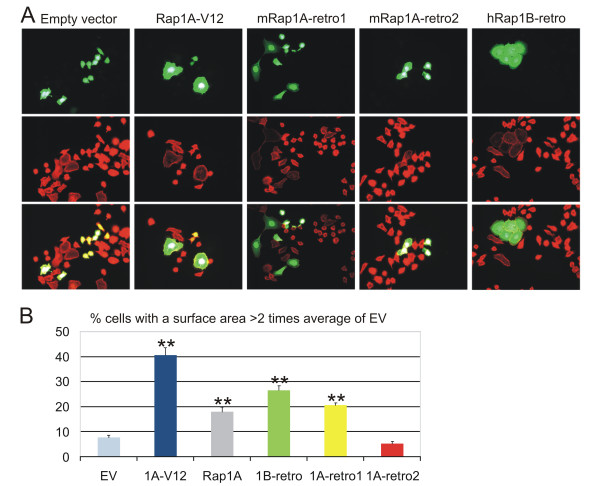
Analysis of the effect of mRap1A-retro1, -retro2 and hRa1pB-retro on cell spreading. A. A431 cells were co-transfected with histon2B-GFP and Rap1 constructs as indicated. Cells were grown overnight in tissue culture wells and then photographed. GFP-positive cells were visualized by phalloidin (red) staining. B. For cell spreading, first we determined the average surface of >100 non-transfected cells using the ImageJ program. Next, the surface of at least 90 transfected cells (selected on the basis of the presence of GFP-H2B) from two independent experiments was measured. Cells with a surface area of more than twice that of untransfected cells were scored as spread. ** indicates a p-value < 0.001 (Chi-test).